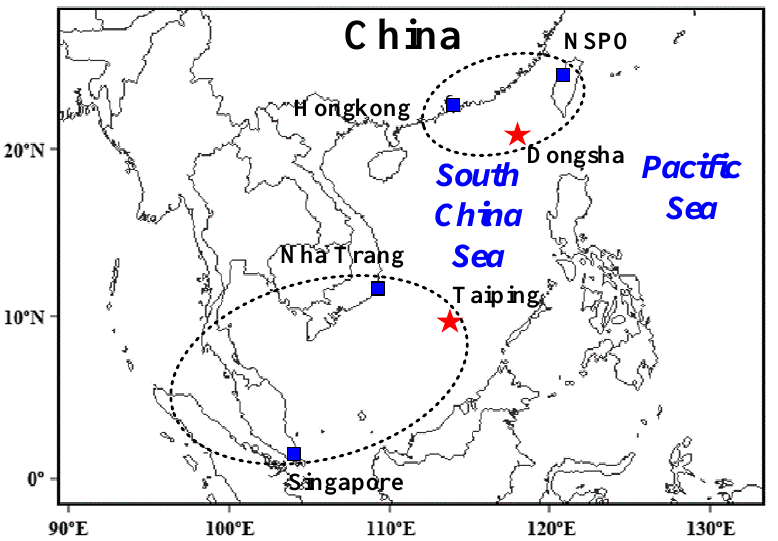
Figure 1. Locations of the observation sites in this study. Dongsha Island and Taiping Island sites are shown as red stars, and other sites are shown as blue squares. All stations are affiliated with AERONET.